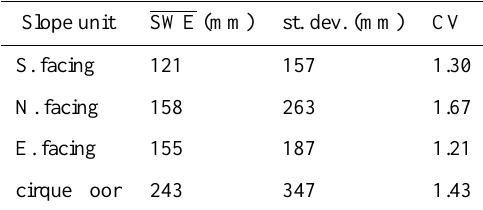
Table 2. Statistical parameters of pre-melt SWE distributions over individual slope units in 2008 based on snow surveys and the Li- DAR snow depth